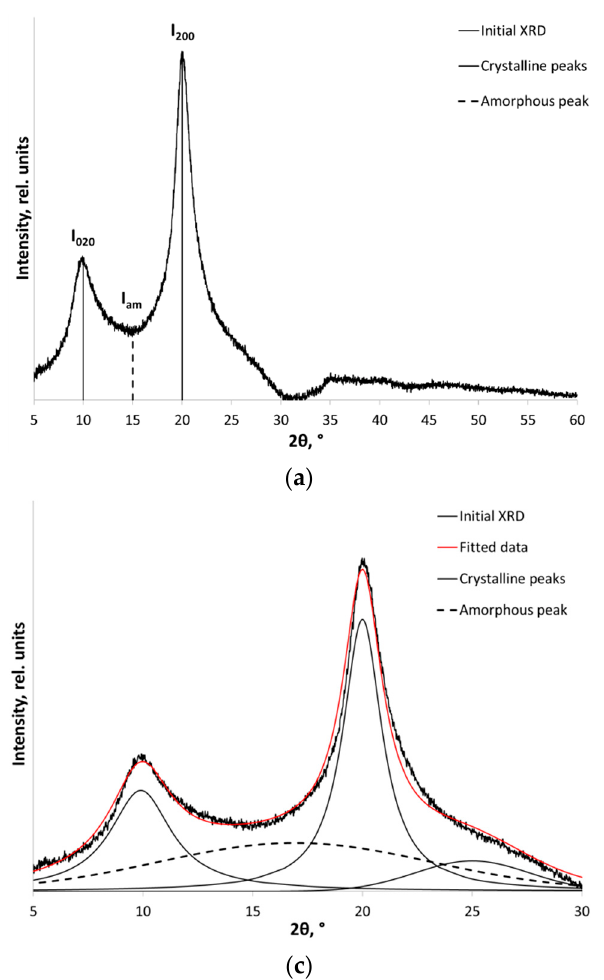
Figure 1. An example of fitting the XRD pattern of chitosan: using ( a ) the peak height method as proposed by Focher; ( b ) the amorphous standard method; and ( c ) the peak deconvolution method. The curves for ( b ) are shifted for clarity as indicated.